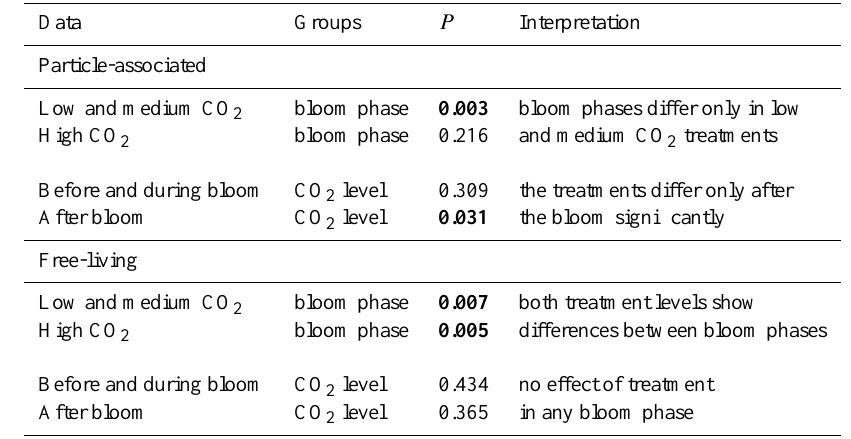
Table 3. One-way analysis of variance (ANOVA) testing for differences in the number of ARISA band classes before and during a phyto- plankton bloom ∗ (phases 0–2) vs. after the bloom (phase 3) as well as in low and medium CO 2 treatment levels ( ∼ 175–600µatm average over experiment) vs. high CO 2 levels ( ∼ 675–860µatm average over experiment). Significant P -values ( < 0 . 05) are given in bold numbers. M7 was not sampled at day −